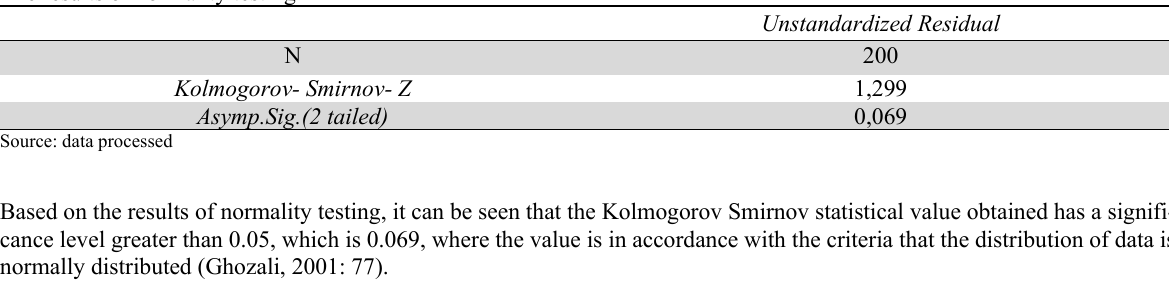
The results of normality testing